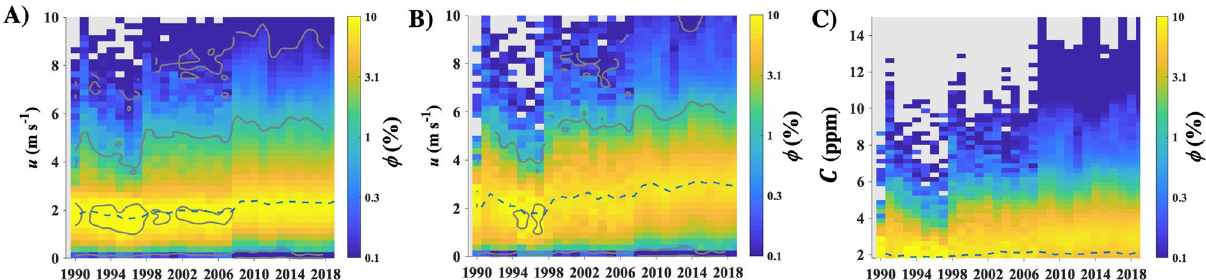
Figure 3. Annual wind speed, u , probability, ϕ ( u ), for ( A ) all directions, ( B ) seep directions (90° < θ < 270°). Contours at ϕ = 0.1, 1, 10%, calculated from 4-year smoothed data. ( C ) Concentration, C , probability, ϕ ( C ), for seep directions. Annual median (dashed line) shown on all panels. Data key on